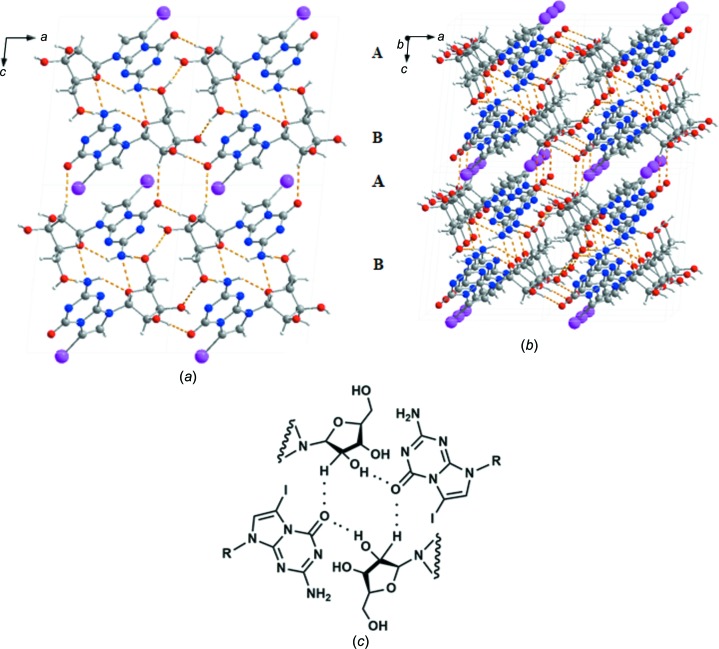
(a) Hydrogen bonding of 1, viewed along the b axis. (b) Multilayered mol­ecular packing of 1, shown along the slightly inclined b axis. (c) Detailed view of part (a), showing the nucleobase–sugar inter­action forming a central core.